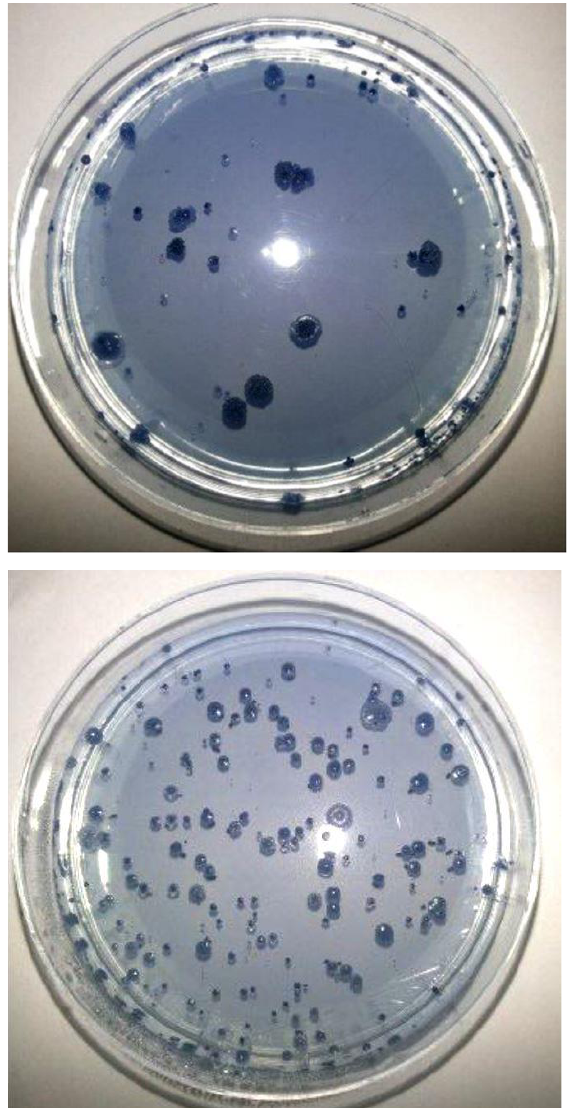
Figure 2 Indicates the number of Streptococcus mutans after applying